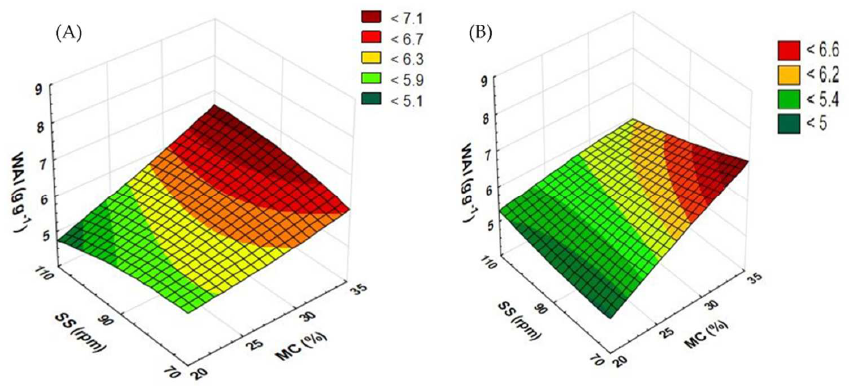
Figure 9. The result of WAI measurement for extruded rapeseed straw ( A ) and buckwheat straw ( B ) after modification of the plasticizing system: MC—moisture content; SS—screw speed; WAI—water absorption index.